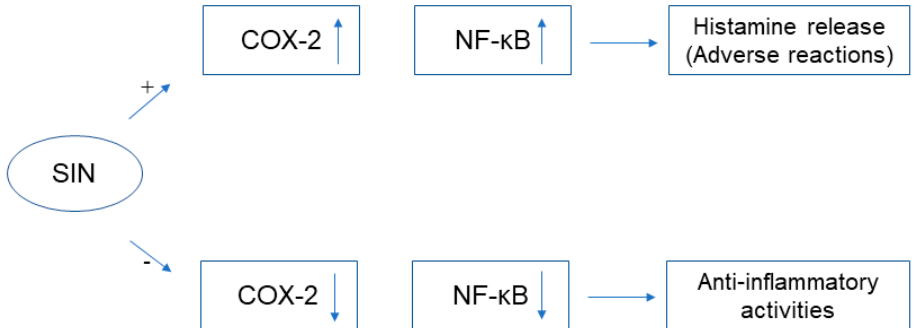
Figure 5. The dual regulation mechanism of SIN, (+) indicated that SIN could up-regulate ( ↑ ) cyclooxygenase-2 (COX-2) expression, activate ( ↑ ) NF- κ B pathway and promote mast cell degranulation to release histamine, further causing adverse reactions; ( − ) indicated that SIN could down-regulate ( ↓ ) COX-2 expression and inhibit ( ↓ ) NF- κ B signaling pathway, thus exerting anti-inflammatory effects.